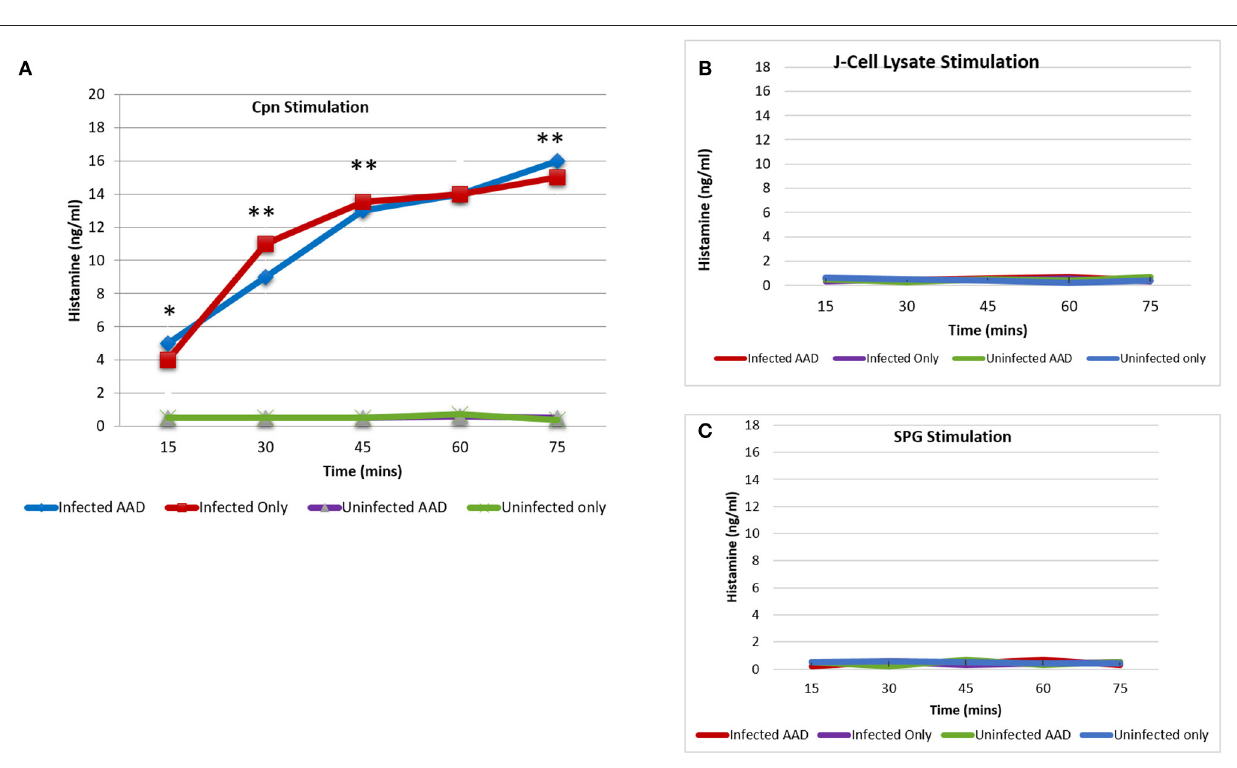
FIGURE 10 | Histamine release from BAL neutrophils in response to chlamydial antigen . BAL neutrophils isolated at day 28 post-infection, were challenged with chlamydial EB antigens in vitro. Subsequent histamine release into the supernatant was assessed using ELISA. BAL neutrophils from infected animals released significant amounts of histamine in response to chlamydial antigen challenge. Histamine levels peaked 75min post-stimulation (A) . Neutrophils from uninfected animals had no release of histamine in response to chlamydial stimulation (A) . Histamine release was undetectable in any group, in response to stimulation with SPG or J774A.1 cell lysate proteins (B,C) . The data confirms the requirement for Chlamydia sensitization by the airway neutrophils for histamine production and subsequent release. Each point on the curve represents the mean ± SEM. Data were analyzed with a paired Student t -test.* P < 0.05; ** P <